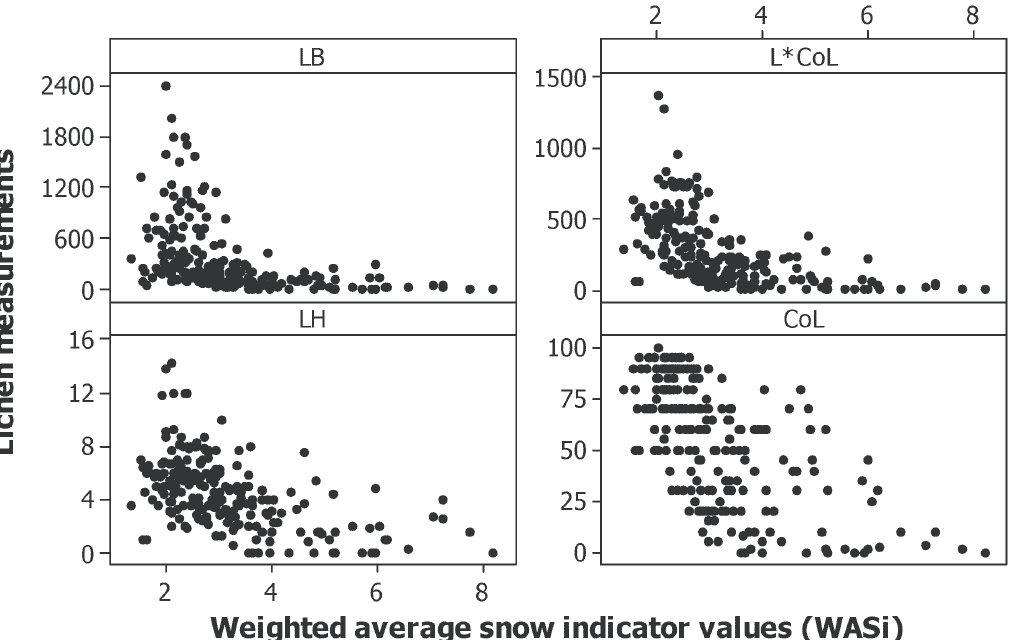
Figure 4. Relationships between average snow indicator value (WA lichen biomass (LB), lichen cover (CoL), lichen height (LH), and lichen volume as estimated by LH ×